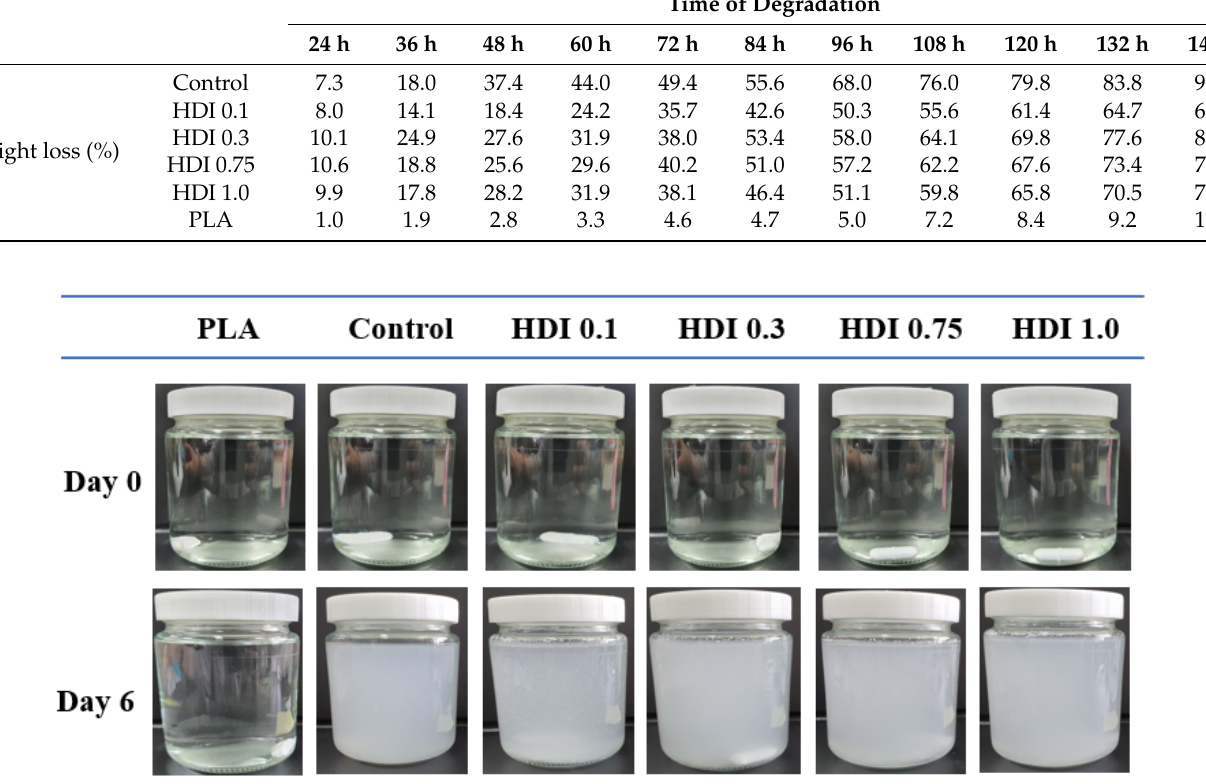
Figure 8. Appearances of neat PLA, control, and blend films prepared with various HDI contents and immersed in NaOH solution at 0 and 6 days.